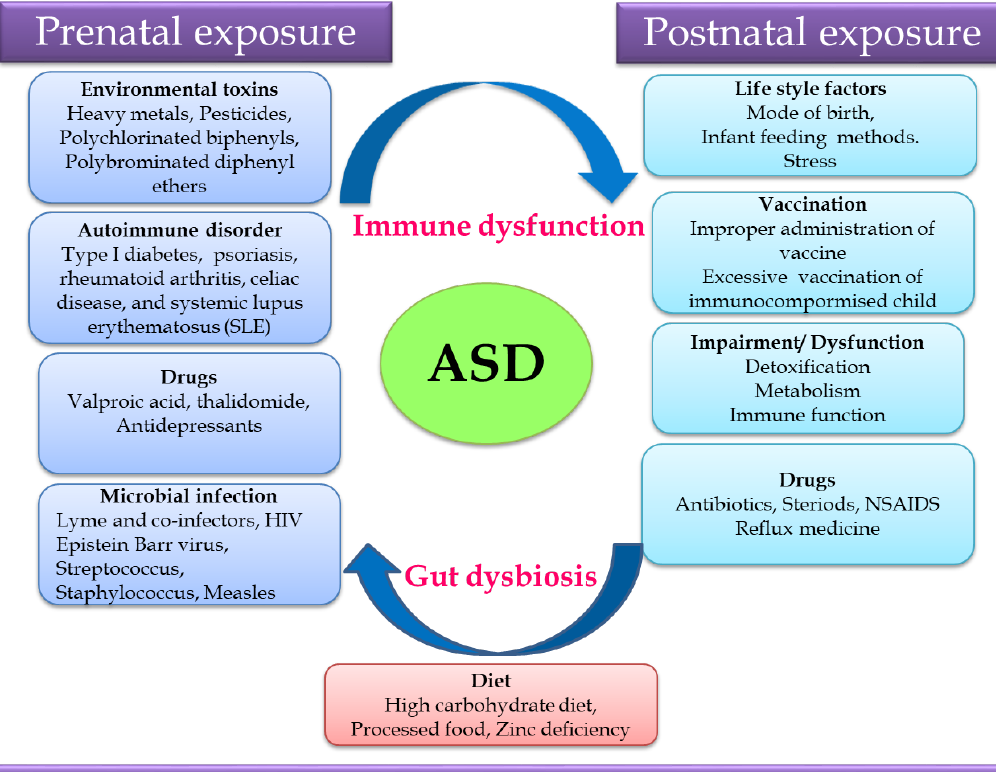
Figure 1. Putative autism spectrum disorder (ASD)-related and environmental factors contributing to ASD.